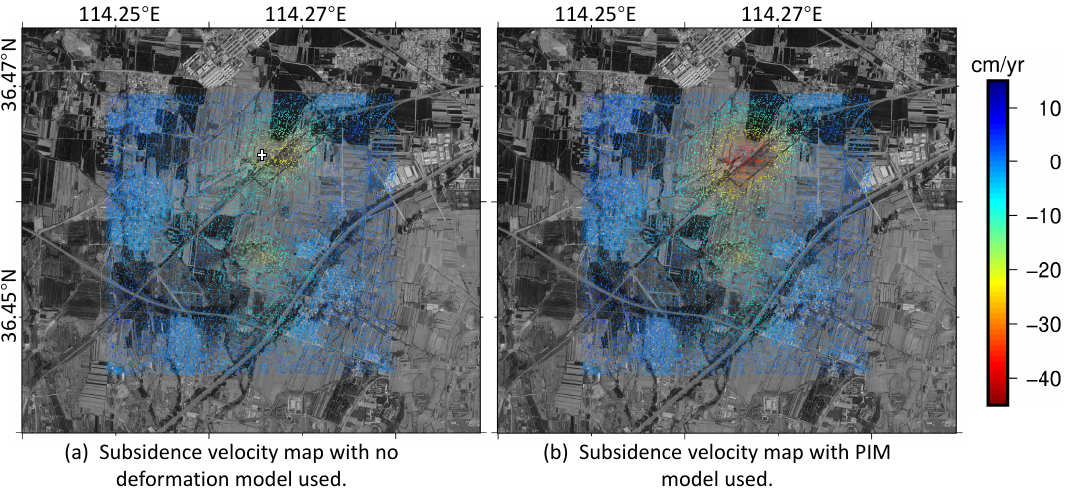
Figure 5. Deformation velocity maps of the study area in vertical direction: the white cross symbol is the point with maximum deformation